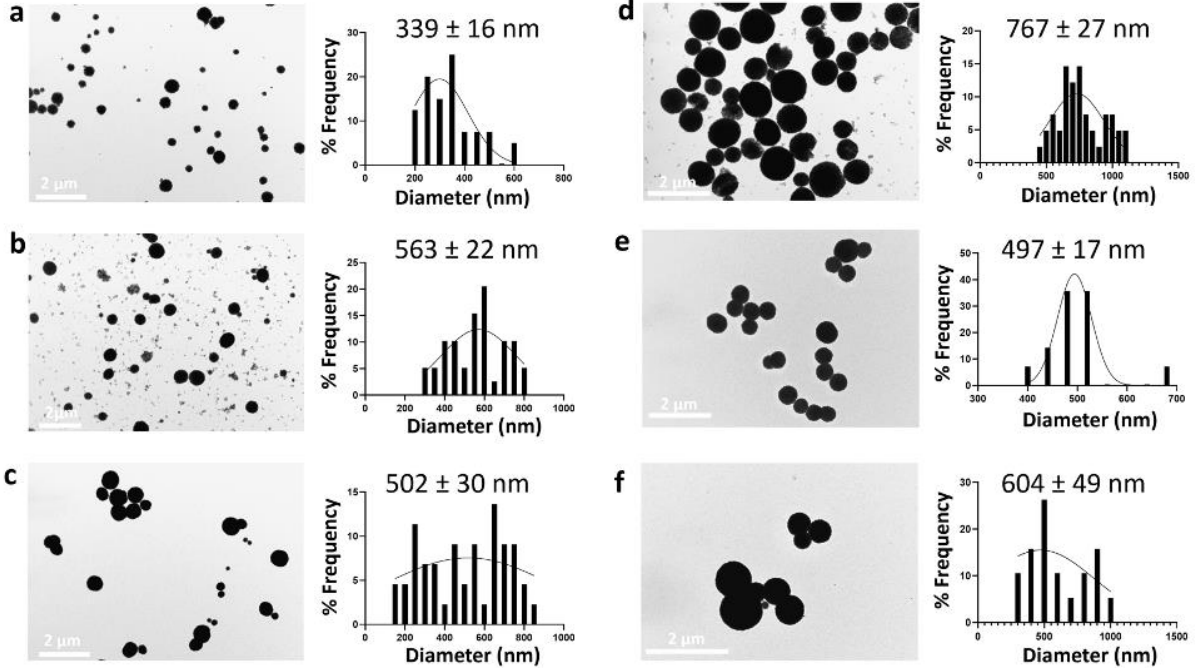
Figure 3. TEM images (left) and size distribution (right) of CaCO 3 NPs prepared using different reaction times, such as 30 min ( a ), 1 h ( b ), 2 h ( c ), and 3 h ( d ), and reducing the H 2 O/EG ratio at 1:3 ( e ) and 1:1 ( f ).